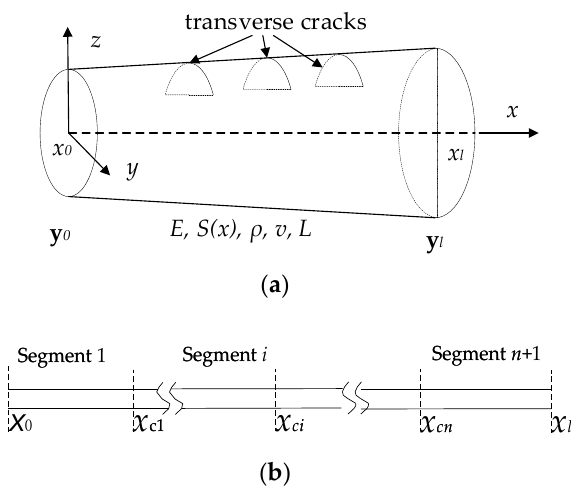
Figure 1. A schematic of a non-uniform shaft with transverse cracks, the cross-section varies with the location of x , as shown in ( a ), the shaft is divided into n + 1 segments by n transverse cracks, as shown in ( b ).